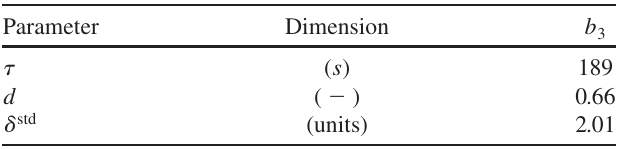
TABLE I. Parameters obtained to fit the sextupole decay in the main dipoles according to Eq. (4), based on magnetic measure- ments.